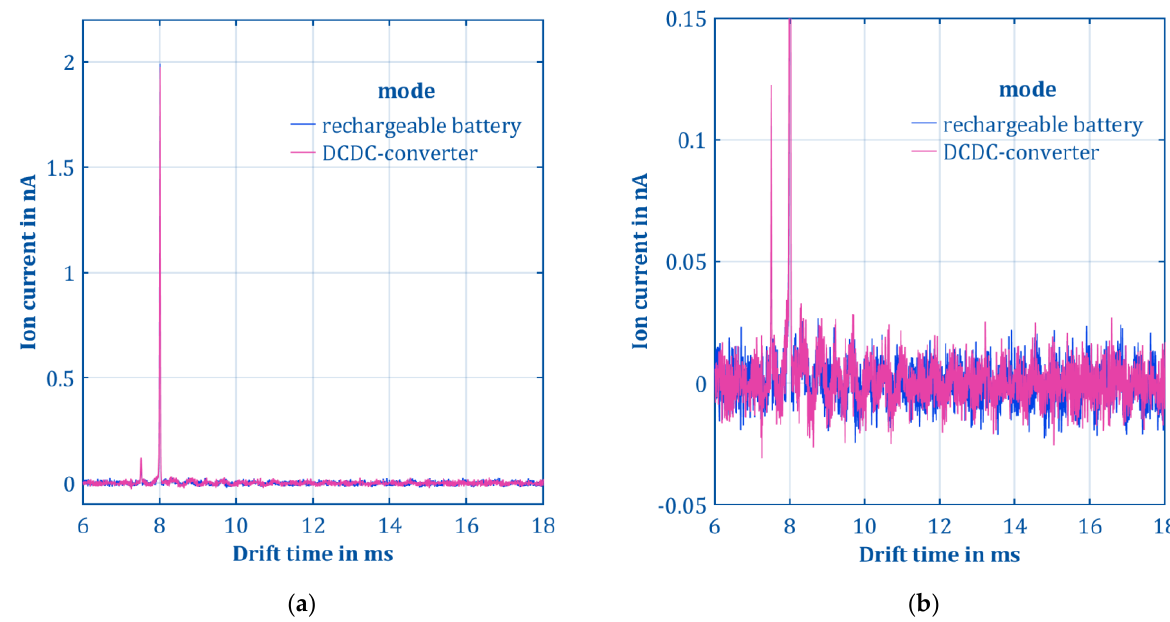
Figure 10. ( a ) Ultra-high resolving power IMS (R p = 270) measurement with different power supplies for isolated signal amplification and data acquisition. The blue ion mobility spectrum is recorded using a rechargeable battery and the red ion mobility spectrum using two isolated DC power supplies connected in series. The standard deviation from 9 to 18 ms is 8 pA and is identical for the isolated DC power supply and the rechargeable battery. All parameters used for the operation of the IMS are shown in Table A2. ( b ) The same spectra from Figure 10a are shown, but the range of the y-axis is modified to show the signal to noise ratio for both the isolated DC power supply and the rechargeable battery.